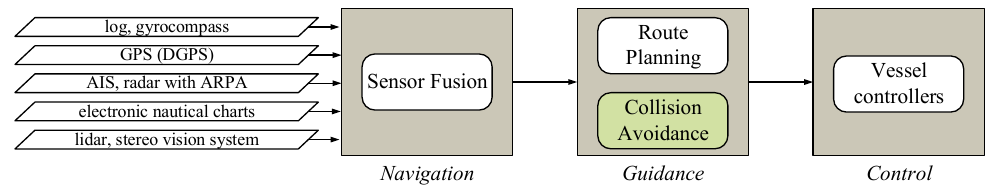
Figure 2. Autonomous Navigation System for